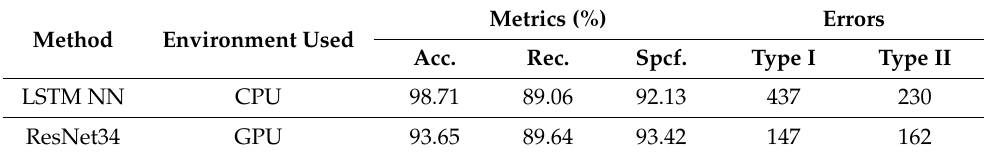
Table 5. Summary of evaluation of two models.